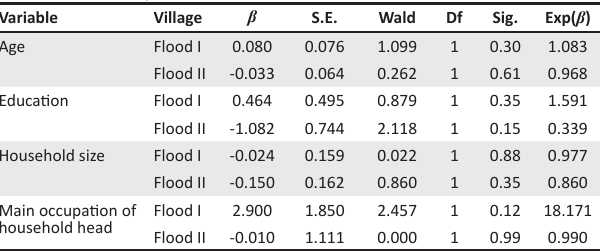
TABLE 4: Human capital variables.